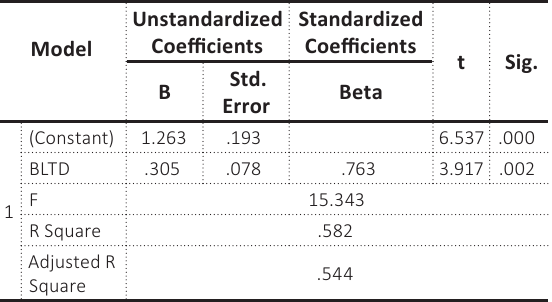
Table 8. Regression analysis testing